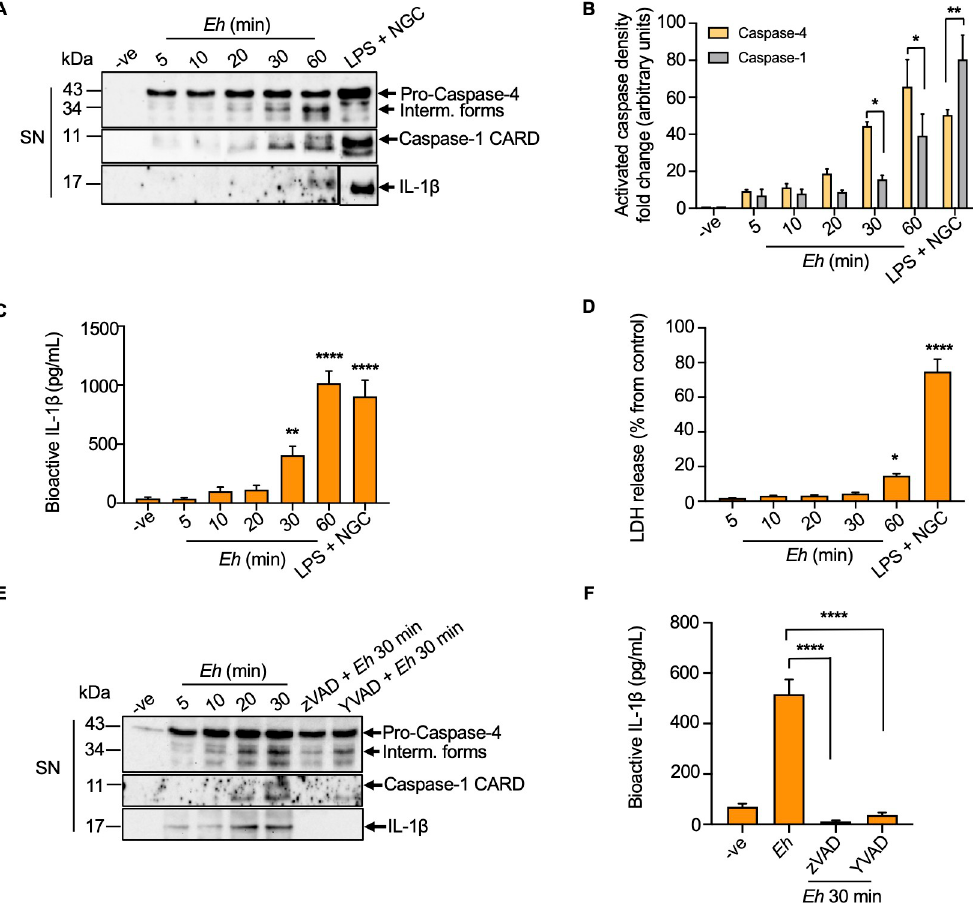
Fig 1. E . histolytica activates caspase-4 and caspase-1 in a time-dependent manner. The kinetics of Eh -induced caspase-4 activation was detected by incubating PMA-differentiated THP-1 macrophages for increasing amounts of time with 1:20 Eh to macrophage ratio. ( A ) Macrophages were incubated for increasing amounts of time with 1:20 Eh to macrophage ratio. Lipopolysaccharide (LPS) (50 ng/mL) and nigericin (NGC) (10 μ M) stimulation for 60 min was used as a positive control. Immunoblot analysis was performed for caspase-4 and caspase-1 in supernatants (SN). ( B ) Quantifications of activated caspase-4 and caspase-1 were performed by densitometric analysis from three independent experiments and the negative control (cells only) acted as an internal control. Statistical significance was calculated between caspase-4 and caspase-1 at each time point. ( C ) Cell free supernatant was added to HEK-Blue IL-1 β reporter cells to detect bioactive IL-1 β via measurement of SEAP levels. ( D ) Cell death was quantified by lactate dehydrogenase (LDH) release into the culture supernatant and is shown as a percentage of LDH release compared to non-stimulated cells (control). ( E, F ) Macrophages were pre-incubated with the pan-caspase inhibitor Z-VAD-fmk (100 μ M) and caspase-1 specific inhibitor Z-YVAD-fmk (100 μ M) for 45 min followed by stimulation with Eh for 30 min. Caspase-4/1 activation as well as IL-1 β secretion in the cell supernatant were assessed via immunoblotting. Cell free supernatant was added to HEK-Blue IL-1 β reporter cells to detect bioactive IL-1 β using the SEAP assay. Data and immunoblots are representative of at least three experiments (n = 3) and statistical significance was calculated with ANOVA and Bonferroni’s post-hoc test ( � p < 0.05, �� p < 0.01, ���� p < 0.0001). Bars represent mean ±